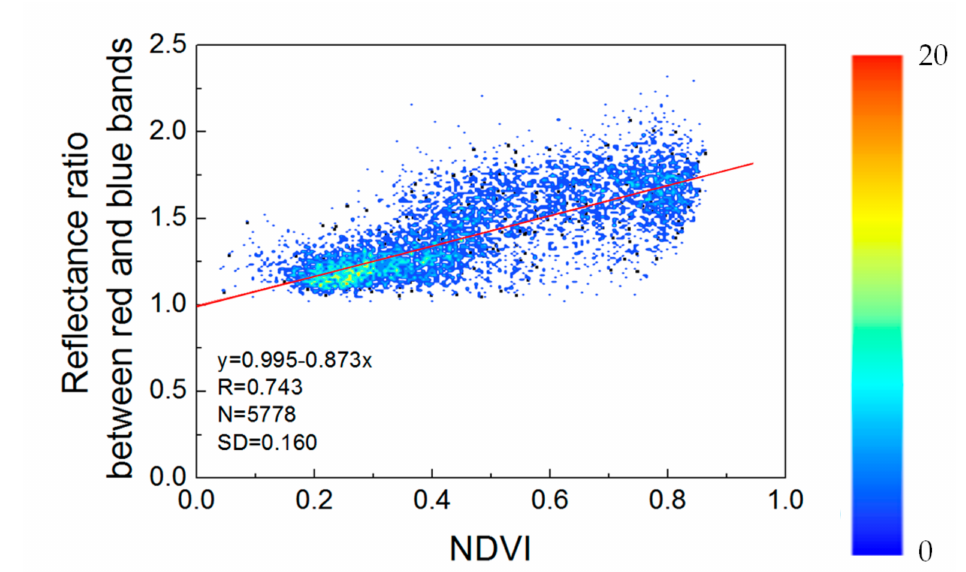
Figure 8. Scatter plot of the NDVI versus the ratio a in Equation